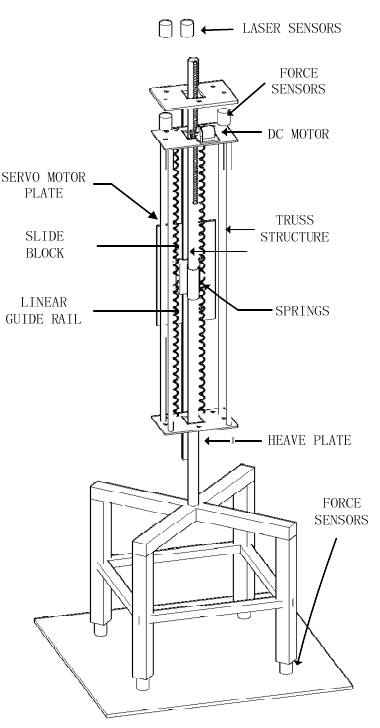
Figure 3. Experimental setup of the THPEH test.